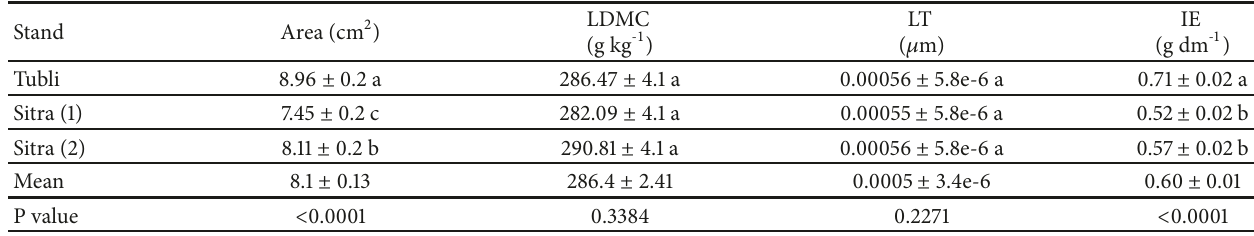
Table 3: Leaf morphological parameters of Tubli Bay mangroves at the study sites ∗